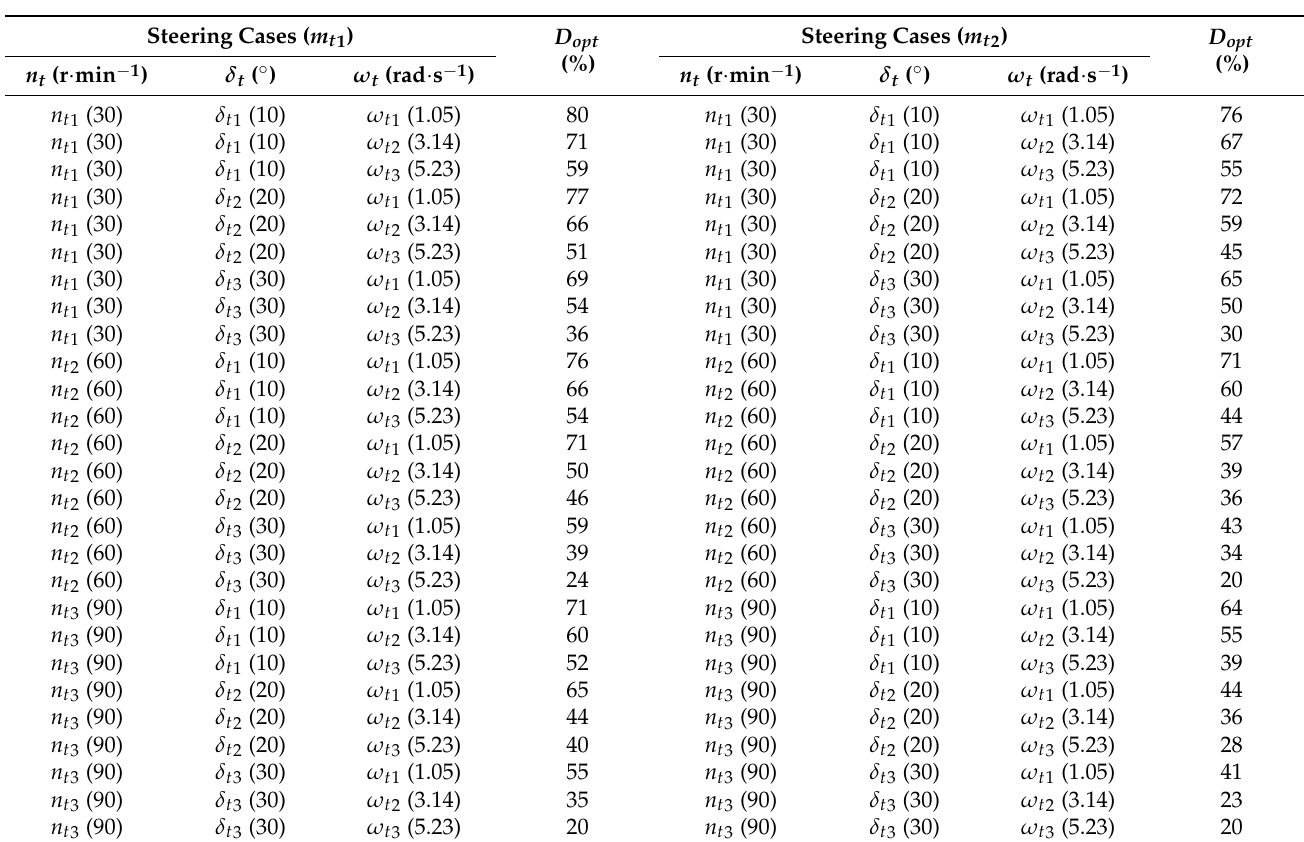
Table 2. Optimal duty cycles under different test